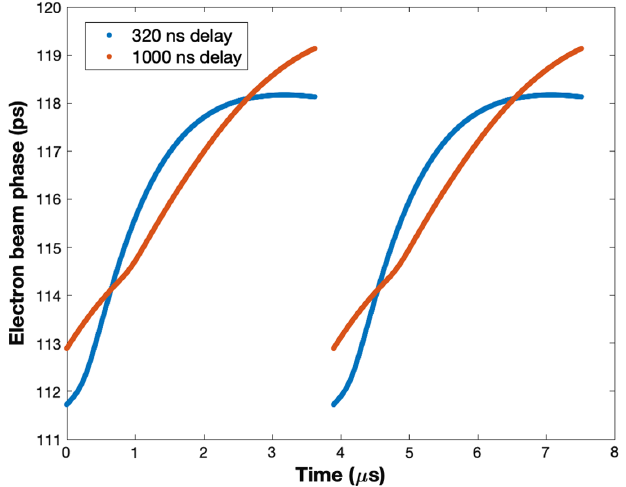
FIG. 23. Gap transient estimates for 320 and 1000 ns